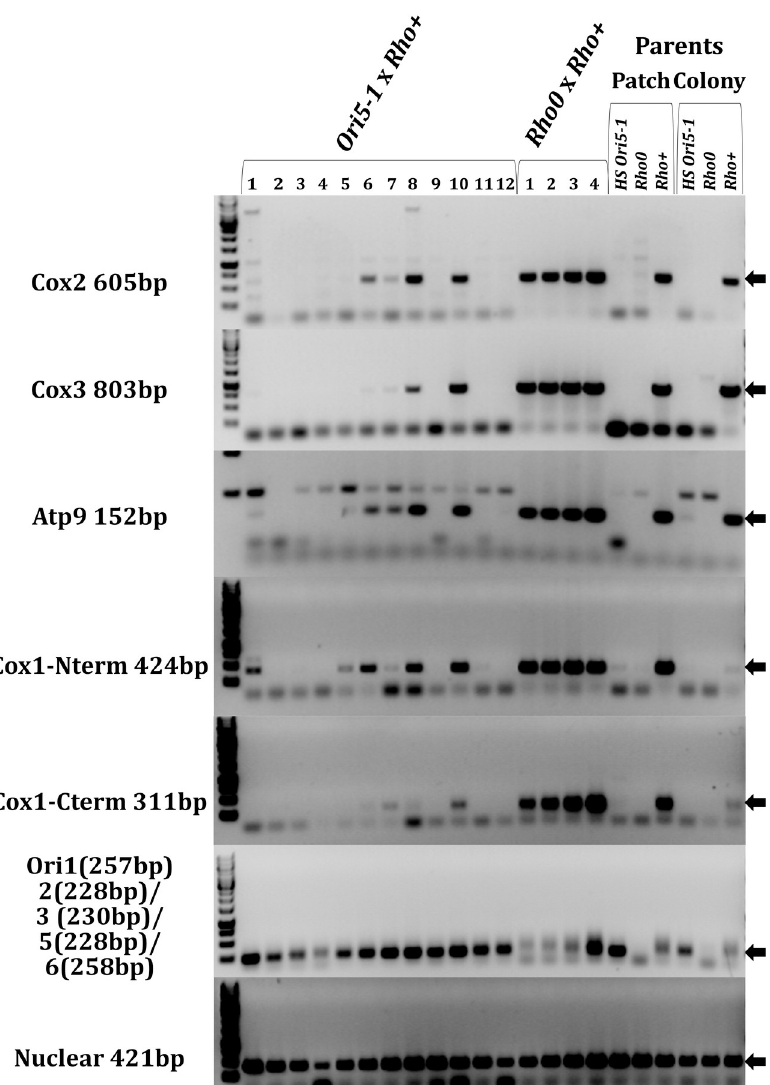
Fig 2. Colony PCR after HS x rho+ Reveals Remnants of rho+ mtDNA. The indicated strains were mated and plated on diploid selection medium. The parent strains were plated to single colonies. After two days, individual colonies were scraped off the plates, and DNA was isolated. Genomic DNA was normalized, and PCRs were performed with primer sets amplifying the indicated loci. Reactions were run on agarose gels and stained with ethidium bromide. Arrows indicate the size of the intended